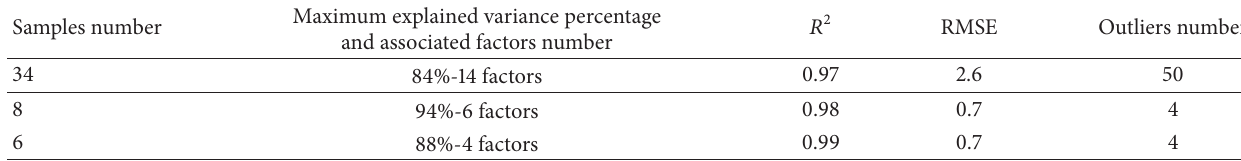
Table 2: Configurations for PLS calculations on the urban stretch.